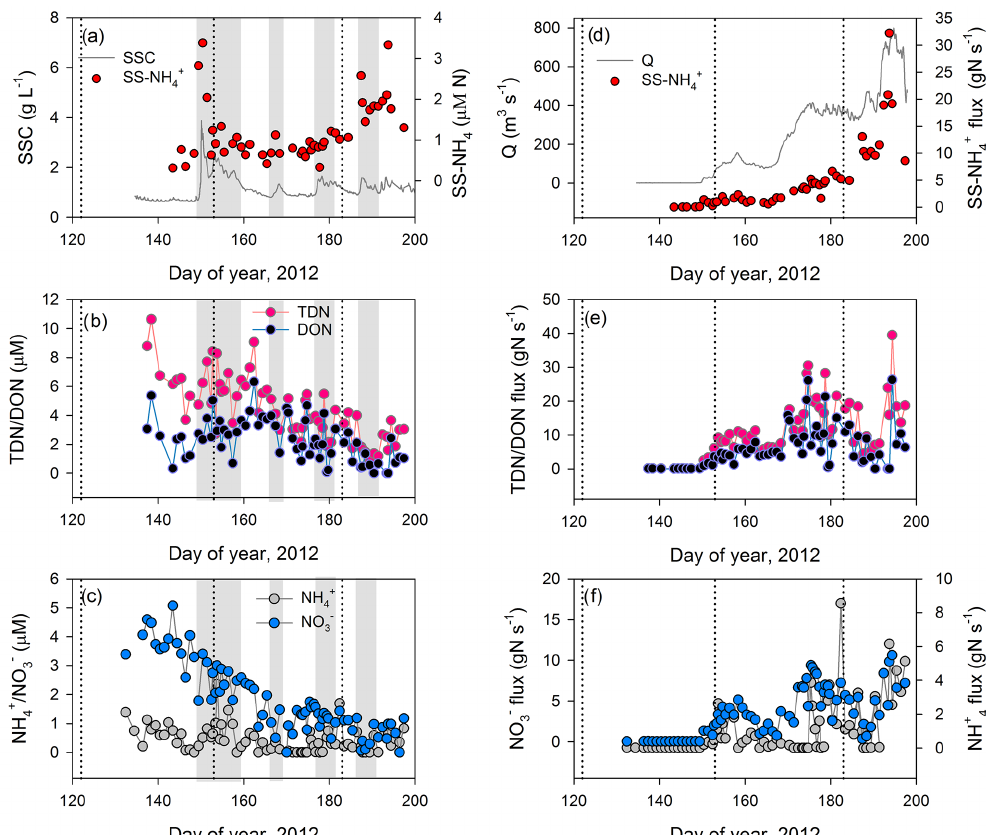
Figure 2. Times series of nitrogen species in LG runoff from the 2012 melt season depicting concentrations of (a) bulk meltwater suspended sediment and sediment-bound ammonium (SS-NH + ; b ) TDN and DON, (c) dissolved nitrate and ammonium, and instantaneous fluxes of 4 (d) SS-NH + (bulk meltwater discharge, Q , is also shown), (e) TDN and DON, and (f) dissolved nitrate and ammonium. Vertical dotted lines 4 (left to right) indicate 1 May, 1 June and 1 July 2012. The grey shaded bars reflect inferred subglacial outburst events (Hawkings et al.,